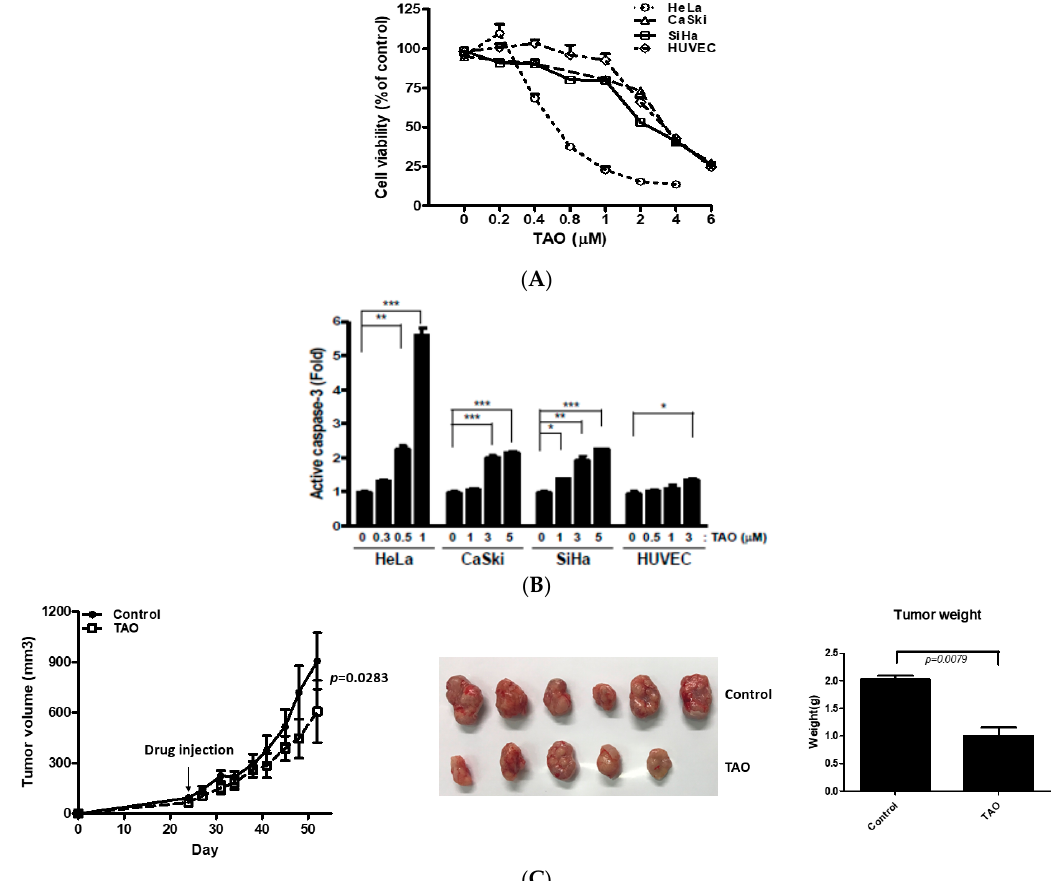
Figure 1. ( A ) Cellular metabolic activities in cervical cancer cell lines and human umbilical vein endothelial cells (HUVECs) measured by MTT assay. Decreasing cell viability with increasing concentration of tetraarsenic hexoxide (TAO) is shown; ( B ) Increasing levels of active caspase-3 are shown in cervical cancer cell lines and HUVECs as the concentration of TAO increases; ( C ) Significant difference is observed in tumor volumes between the mice bearing SiHa cells treated with TAO vs. 0.9% sodium chloride solution. The days represent post-implantation of tumor cells. TAO or 0.9% sodium chloride solution was injected once the tumor grew to a certain volume, which was about 85.5 mm 3 in the present experiments. The mean weight of the treatment group vs. control group shows a statistically significant difference. * p -value < 0.05, ** p -value < 0.01, *** p -value < 0.001. Table 1. IC 50 values of TAO on HeLa, CaSki, SiHa cell lines and HUVEC measured by